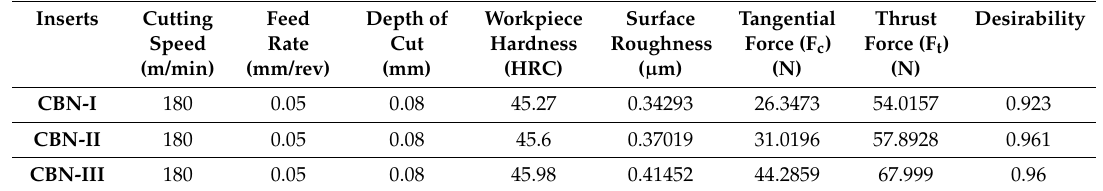
Figure 10. ( a ) Contour Plots of Desirability Function for CBN-I Inserts; ( b ) Contour Plots of Desirability Function for CBN-II Inserts; ( c ) Contour Plots of Desirability Function for CBN-III Inserts. Table 15. Desirability summary from results of different inserts.